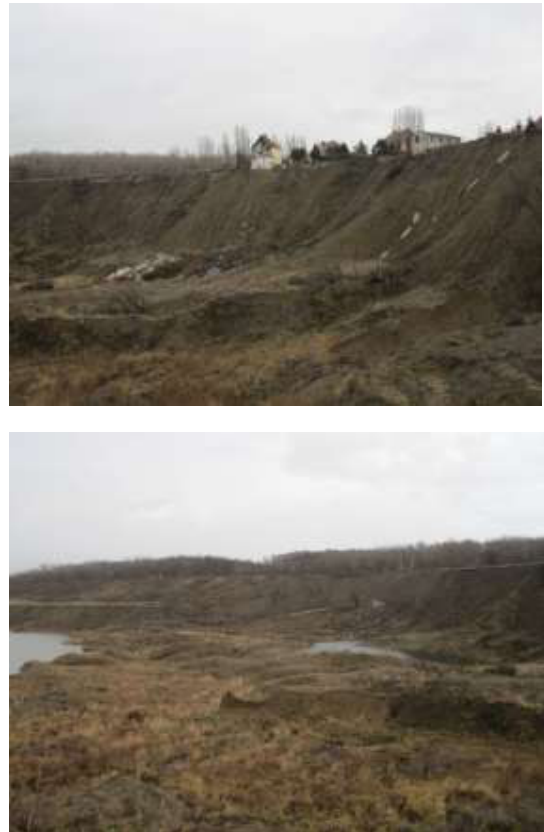
Figure a, b A landslide washed away parts of a housing development near the former coal mine